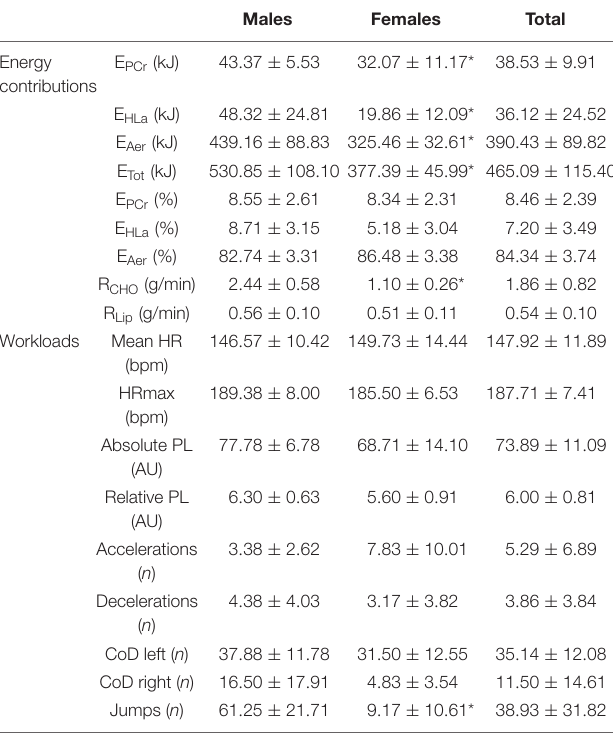
TABLE 3 | Descriptive results of energy contributions and workloads during stroke practices.